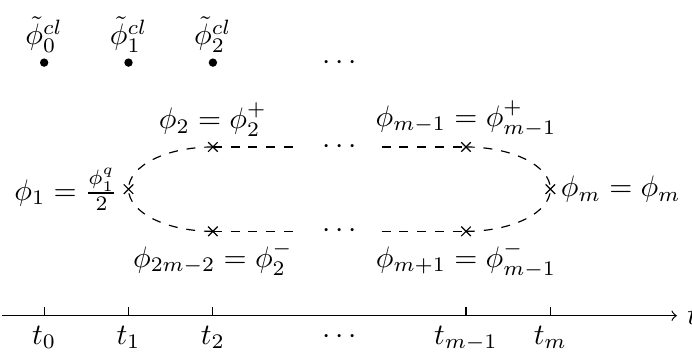
Figure 4 . The variables to be integrated over on the real-time contour, after the initial conditions are